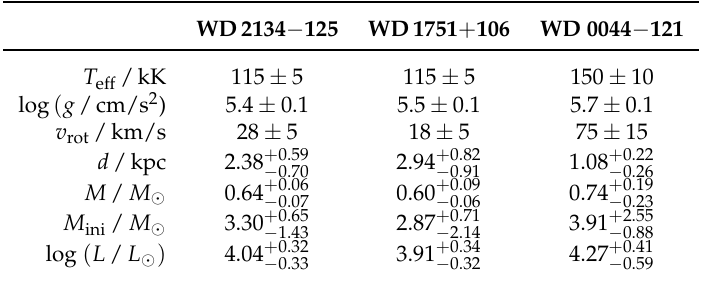
Table 2. Parameters of WD2134 − 125, WD1751 + 106, and WD 0044 −